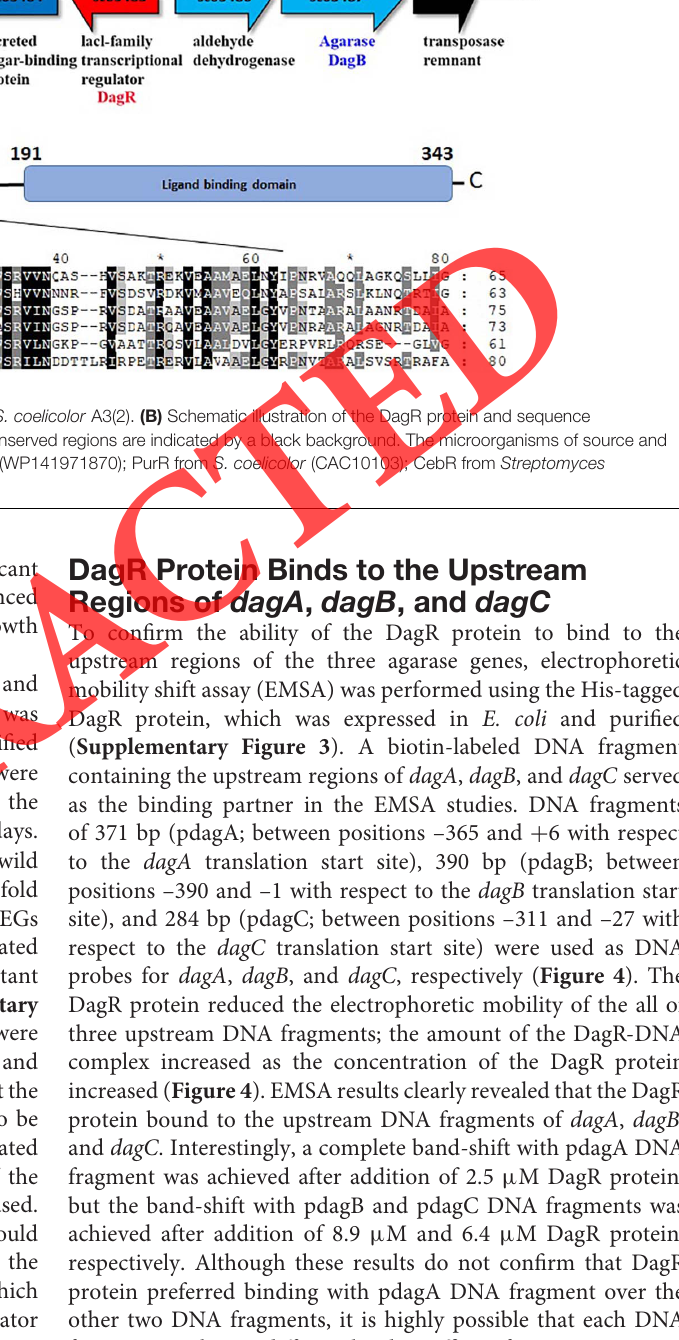
FIGURE 1 | (A) Genomic organization of the agarolytic pathway genes in S. coelicolor A3(2). (B) Schematic illustration of the DagR protein and sequence alignments of the N-terminal region of DagR homologs in which the fully conserved regions are indicated by a black background. The microorganisms of source and accession numbers are: LacI from E. coli (QCB65867); RbsR from Serratia (WP141971870); PurR from S. coelicolor (CAC10103); CebR from Streptomyces (WP003968984); MalR from S. coelicolor (P09371).